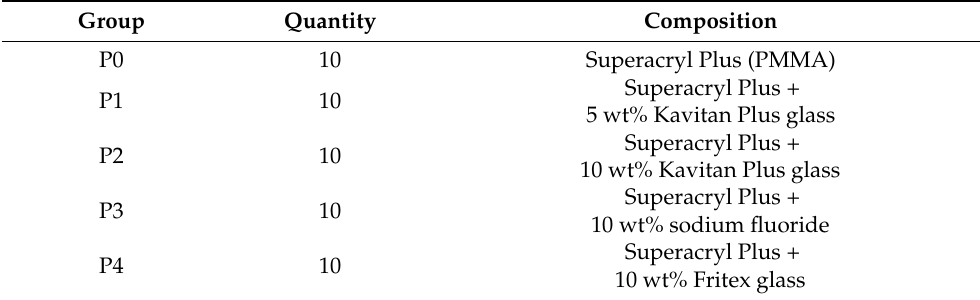
Table 2. Specimen